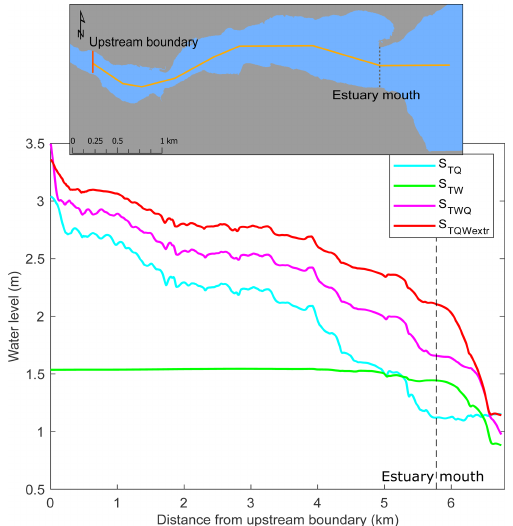
Figure 4. WL (m) with distance from the upstream boundary of all scenarios, with the vertical dashed line demonstrating the location of the estuary mouth. The map shows the location of the transect (yellow line), as well as the location of the upstream open boundary (vertical orange line) and the estuary mouth (dashed grey